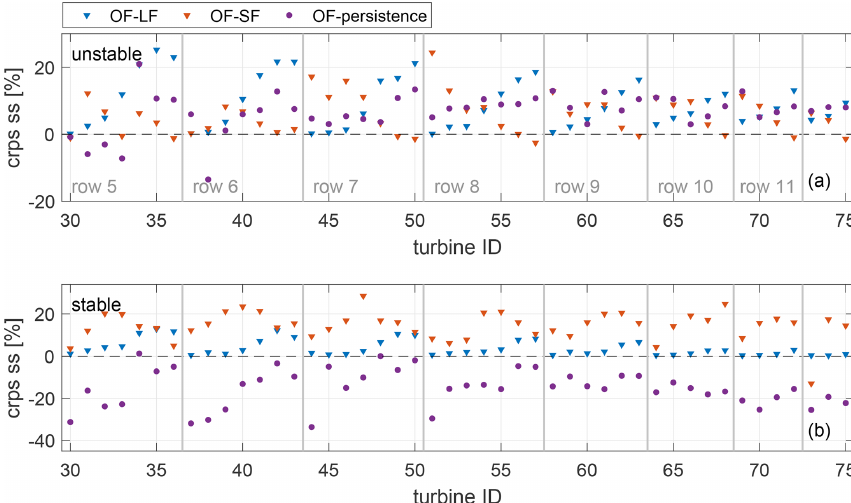
Figure 8. The crps ss of the OF with LF, SF and persistence as reference for individual turbines of GT I and distinguishing between (a) unstable and (b) stable atmospheric conditions. Grey vertical lines mark horizontal wind turbine